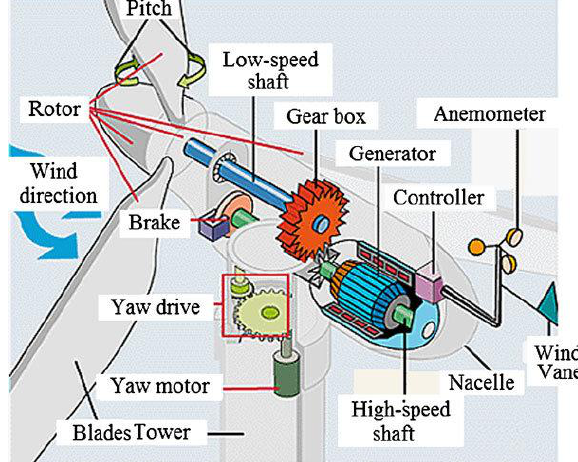
Figure 1. Internal structure of wind turbine